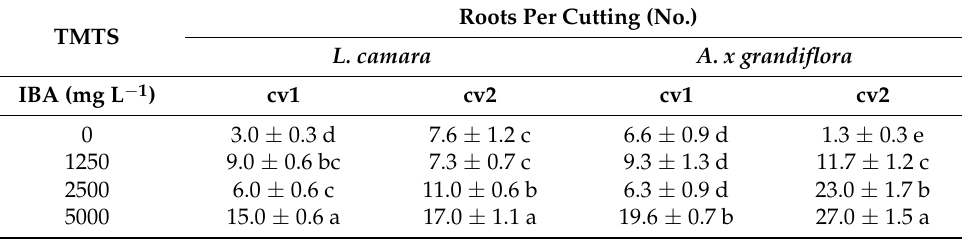
Roots Per Cutting